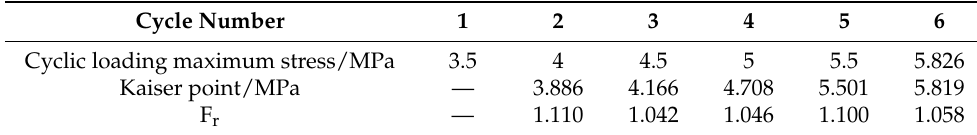
Table 3. The Kaiser effect point and the corresponding Felicity ratio. Cycle Number Cyclic loading maximum stress/MPa